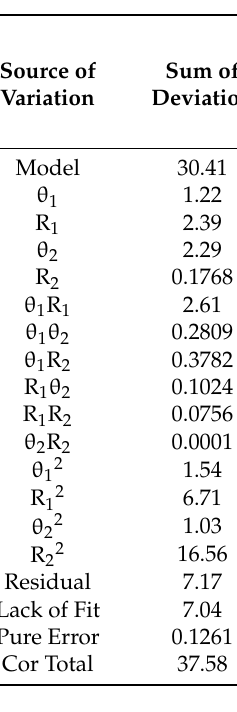
Table 5. Significance test of the regression equation (operational state of pumping).